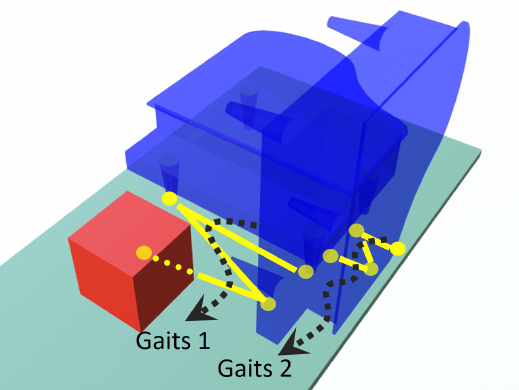
Figure 13. A change of the object’s supporting base improves the ability of collision avoidance. The object motion following the gaits 1 cannot avoid a collision with the red obstacle. If the object is tumbled, the supporting base will be changed. Such a change allows the object to be moved without colliding the obstacle by performing the gaits 2. To pass a narrow passage, gaits 2 is more area-efficient than gaits